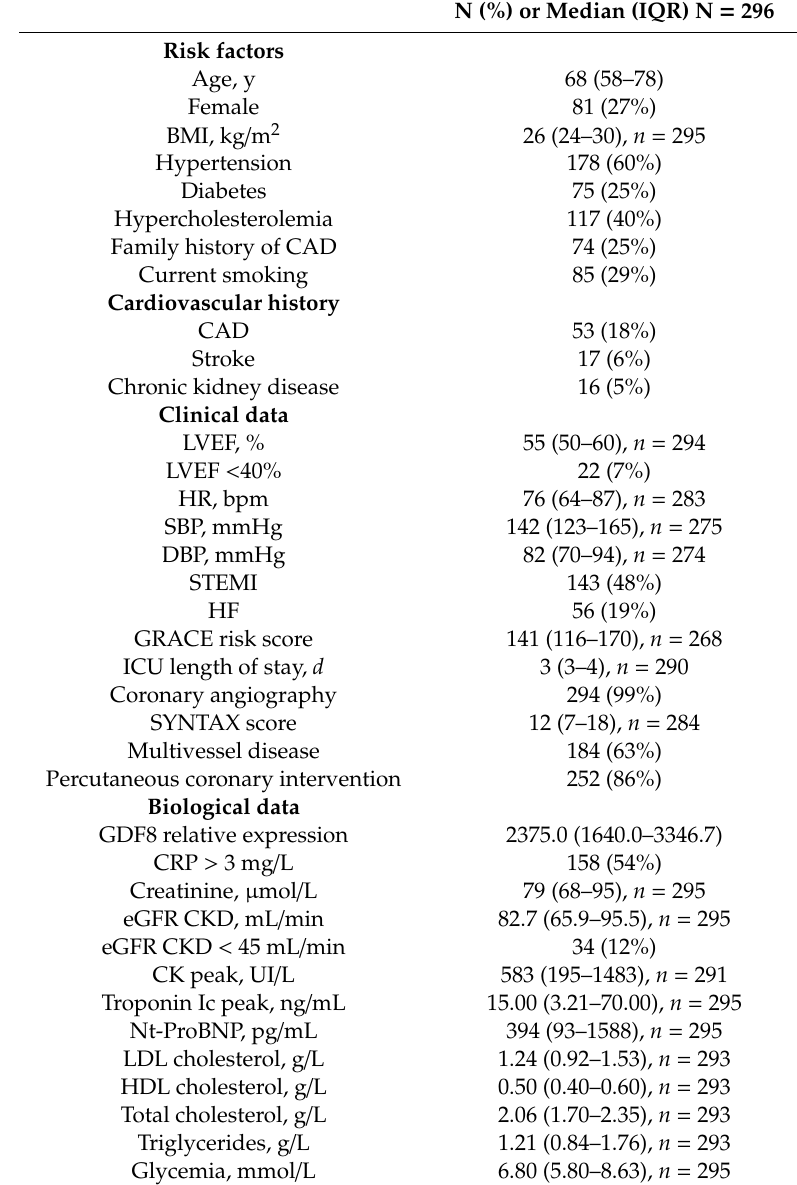
Table 1. Baseline